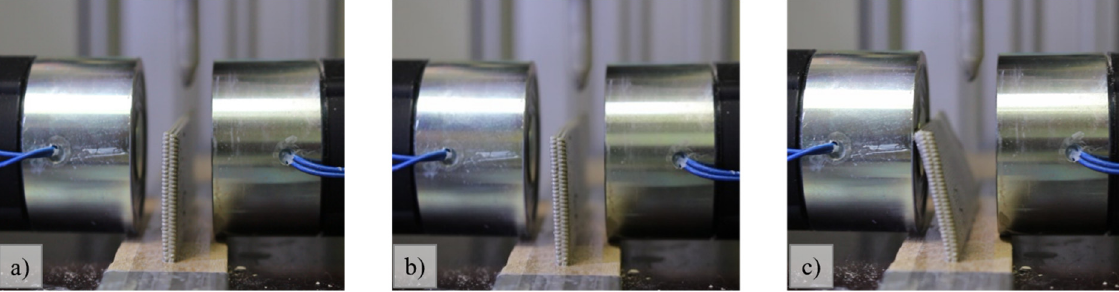
Figure 9. Wall tilting: ( a ) starting position; ( b ) tilting the wall to the left; ( c ) collapsing wall.